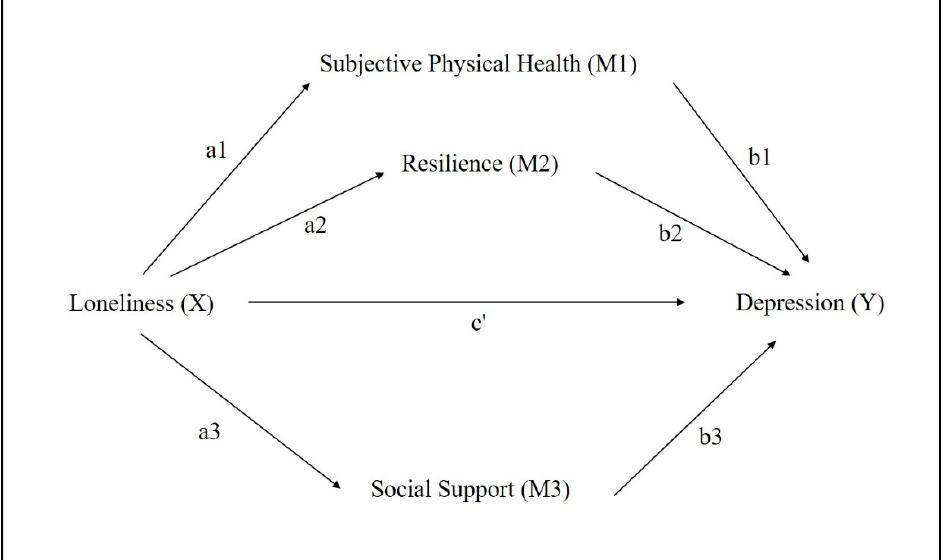
respectively (Figure 2).